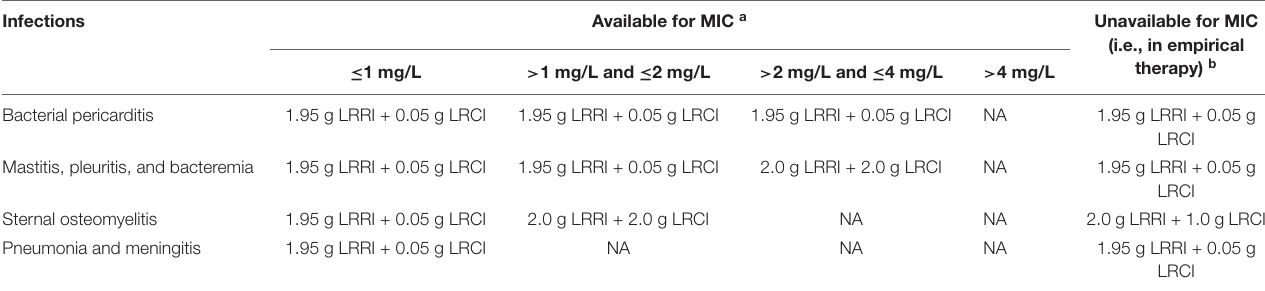
a determined by such a regimen that has a lower daily dose and a PTA of ≥ 90%; b determined by such a regimen that has a lower daily dose, a wider coverage of bacterial species and a CFR of ≥ 90%. NA, (VAN) not applicable.